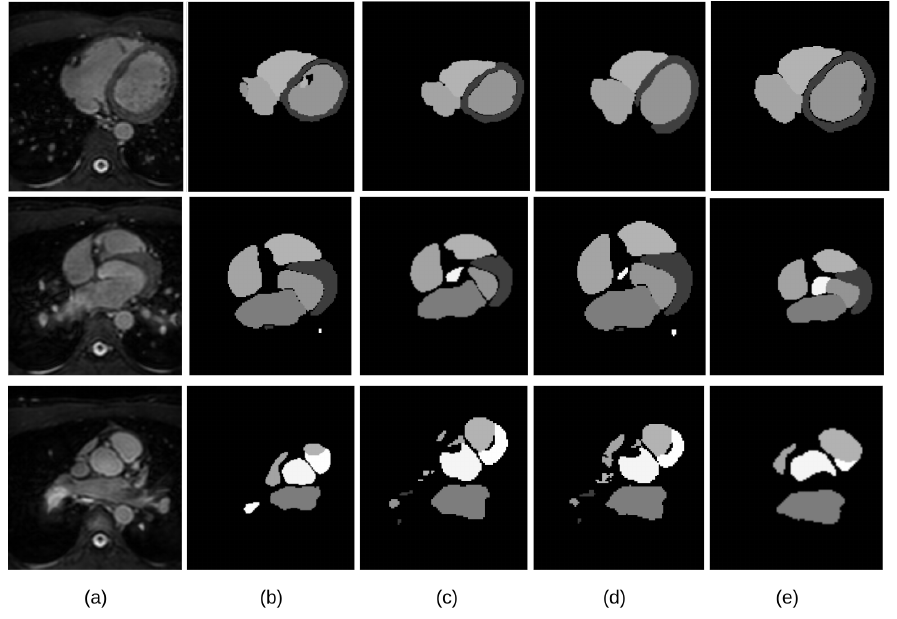
Figure 11. Comparison of the results for four different network architectures. ( a ) the input original MRI images; ( b ) segmentation results of Pre-ResNet without VAE; ( c ) segmentation results of Pre- ResNet with VAE; ( d ) segmentation results of FM-Pre-ResNet without VAE; ( e ) segmentation results of the proposed FM-Pre-ResNet with VAE obtains the most accurate results on the testing